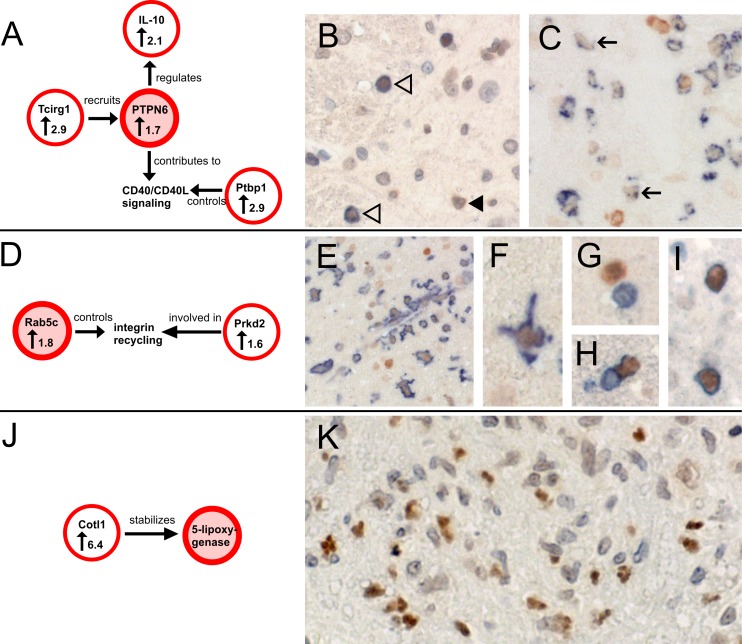
Histological confirmation of the expression and cellular sources of key molecules identified by microarray analysis.(A) Interconnection of Ptpn6 with other molecules differentially upregulated (↑, fold change) in ENMO compared to EAE. Ptpn6 is recruited by Tcirg1 [33,34], regulates the production of IL-10 [35], and contributes to CD40 signaling reciprocity [36]. A critical molecule for turnover and subcellular distribution of CD40L is Ptbp1 [37]. Hence, confirmation of Ptpn6 expression supports gene expression data of three additional differentially expressed genes. (B) Spinal cord section of a Lewis rat with ENMO reacted with antibodies against CD3 (blue surface staining) and Ptpn6 (brown). The section was faintly counterstained with hematoxylin to reveal nuclei in blue. Shown here is Ptpn6 expression in CD3+ T cells (white arrow heads) and in neutrophils with lobulated nuclei (black arrow head). (C) Spinal cord section of a Lewis rat with ENMO reacted with the ED1 antibody (blue) and Ptpn6 (brown). In ED1+ activated microglial cells/macrophages, Ptpn6 expression is low (black arrow). (D) Interconnection of Rab5c, which regulates the endocytic pathway and controls the rates of integrin internalization and recycling [38] with Prkd2, a molecule involved in β1 integrin recycling [39]. Both molecules are differentially upregulated (↑, fold change) in ENMO compared to EAE. (E-I) Spinal cord section of a Lewis rat with ENMO reacted with antibodies against Ptpn6 (brown) and Iba 1 (blue) to show the expression of Ptpn6 in microglia (E,F), CD3 (blue) to show the absence of Ptpn6 expression in CD3+ T cells (G), and W3/13 (blue) to show the expression of Ptpn6 in neutrophils (H,I). (J) 5-lipoxygenase is stabilized by Cotl1 [40,41], a molecule found 6.4-fold upregulated (↑, fold change) in ENMO compared to EAE (S1 Table). (K) Spinal cord section of a Lewis rat with ENMO reacted with antibodies against 5-lipoxygenase (brown). The section was faintly counterstained with hematoxylin to reveal nuclei in blue. 5-lipoxygenase is localized to the lobulated nuclei of neutrophils.